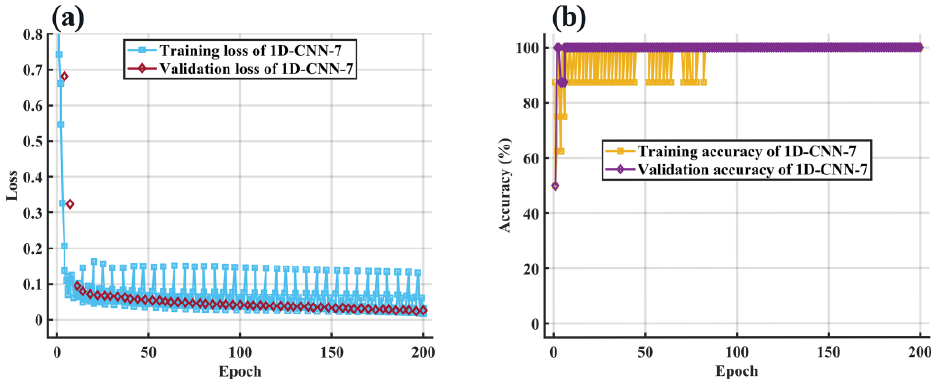
Figure 11. ( a ) The loss and ( b ) the accuracy curve of the 1D-CNN-7 training process.